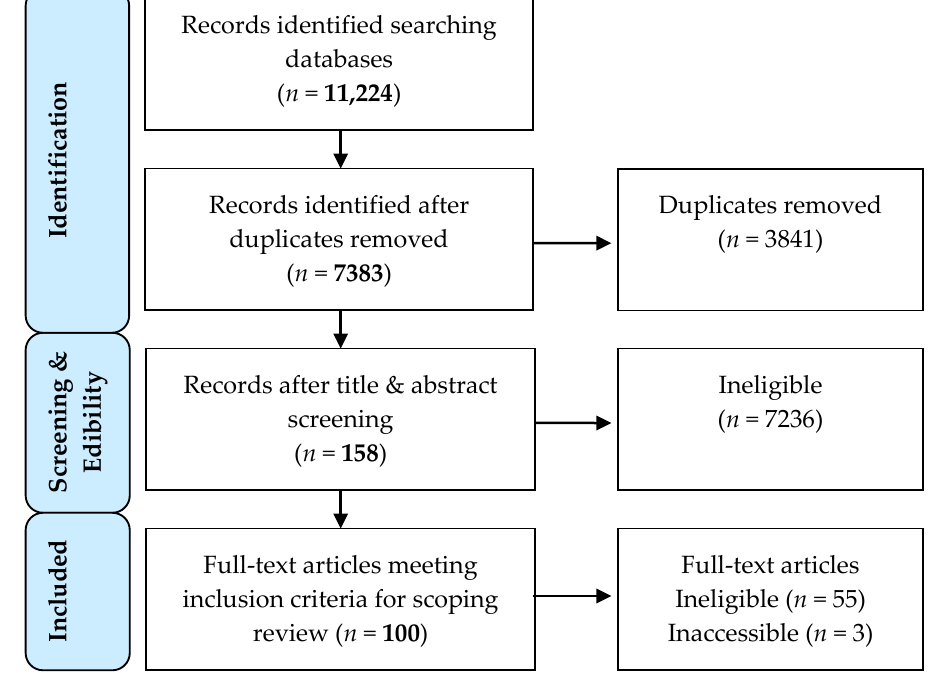
Figure 1. PRISMA flowchart of scoping review process. PRISMA: (Preferred Reporting Items for Systematic Reviews and